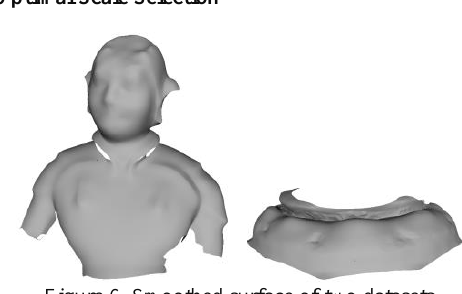
Figure 6. Smoothed surface of two datasets